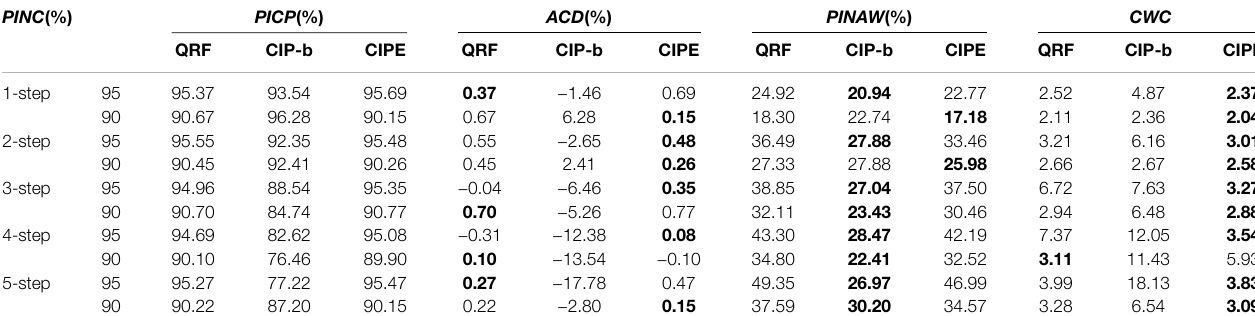
TABLE 2 | Multi-step ahead prediction results of QRF, CIP-b, and CIPE under different PINC . PINC (%) PICP (%) ACD (%)